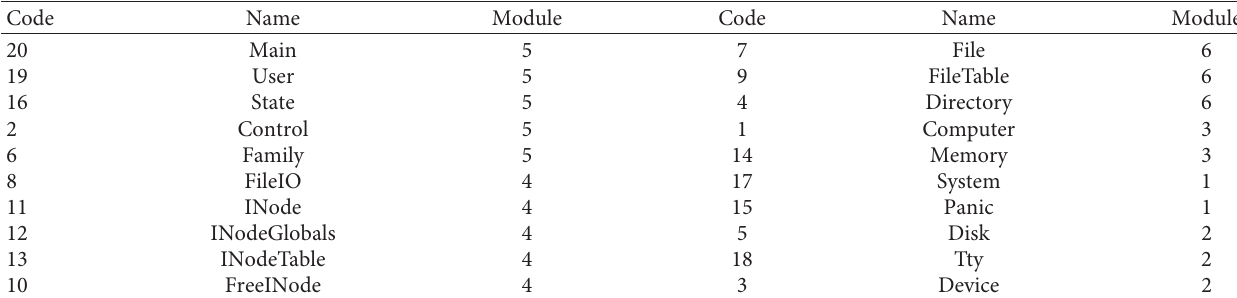
Table 13: Mini-Tunis details.